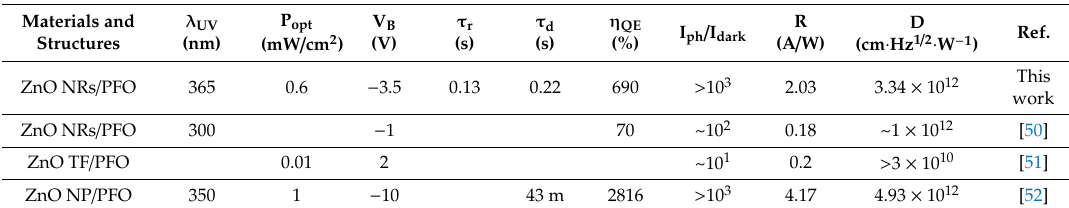
Table 1. Comparison of the photoresponse characteristics for various PFO / ZnO-based organic-inorganic hybrid heterojunction